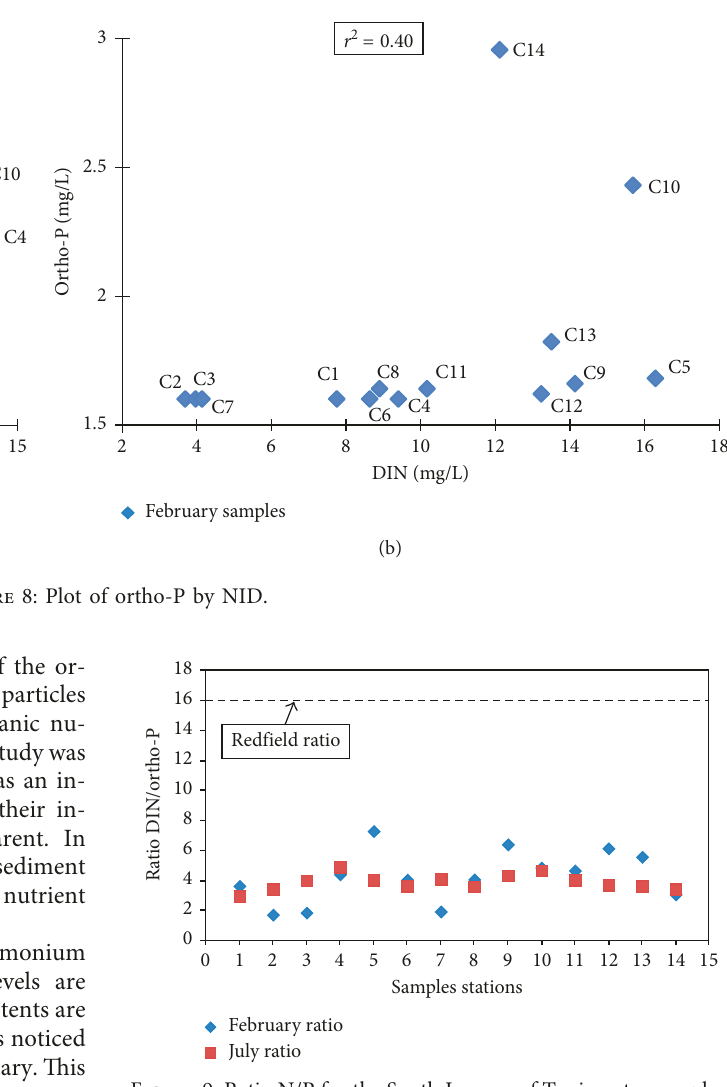
Figure 9: Ratio N/P for the South Lagoon of Tunis water